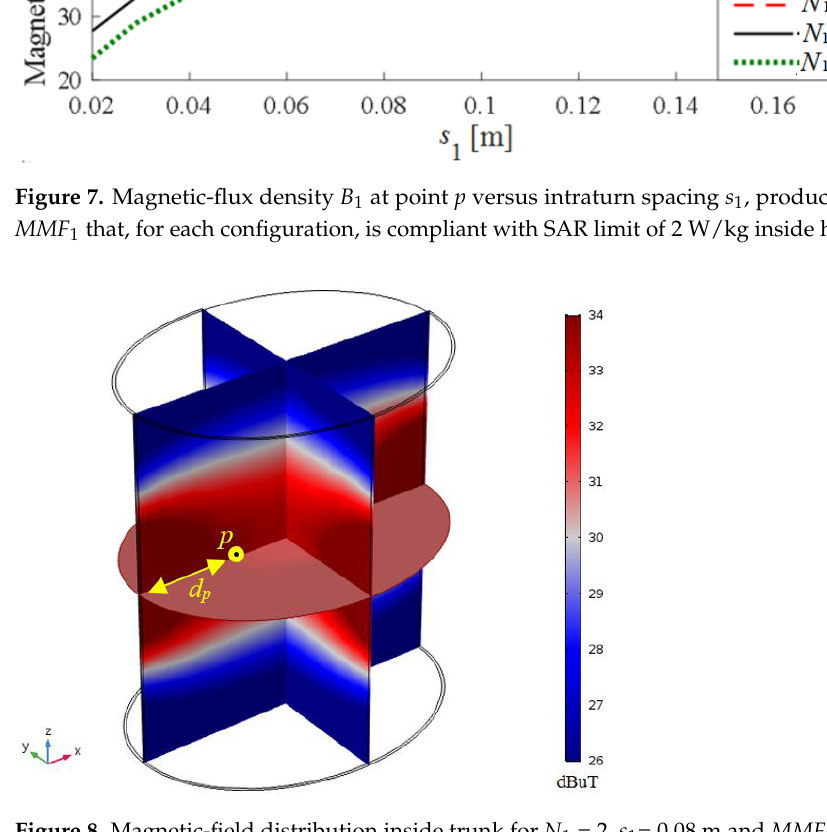
1 = 2, s 1 = 0.08 m and MMF 1 = 14